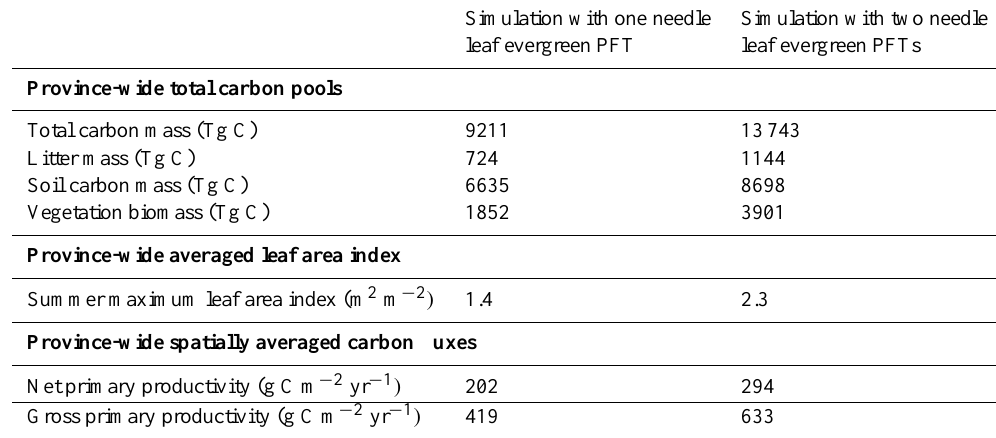
Table A1. Comparison of British Columbia total carbon pools and spatially averaged carbon fluxes averaged over the reference period 1990–2005 from the CLIM + CO 2 simulation for cases where one and two needleleaf evergreen PFTs are